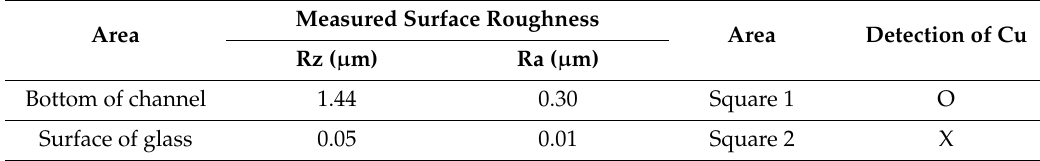
Table 3. Surface roughness and detection of Cu for each area of glass analyzed.